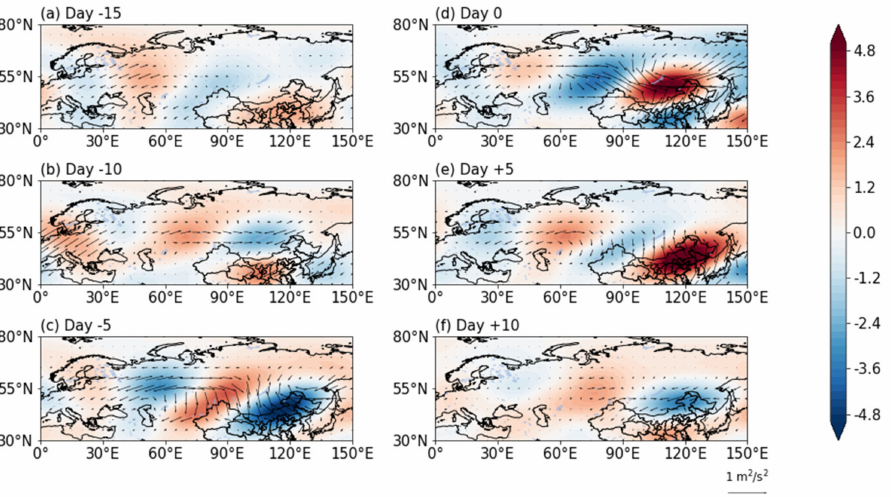
Figure 6. Composite low-frequency stream function (shadings; unit: 10 6 m 2 /s) and wave activity flux (vector; units: m 2 /s 2 ) anomalies at 200 hPa for Day − 15 to Day +10 relative to LFEHT occurrences ( a – f